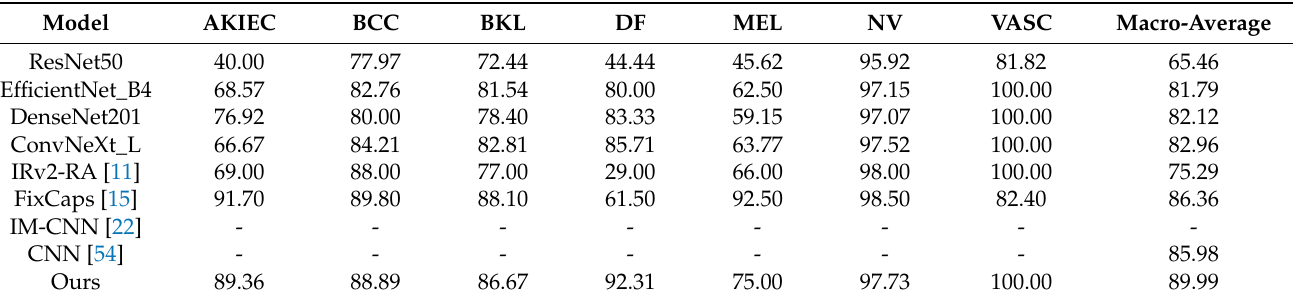
Table 8. The f1-score of each model on the public dataset HAM10000 (test set of 828 images); the missing values of indicators are replaced by “-”, and the unit is